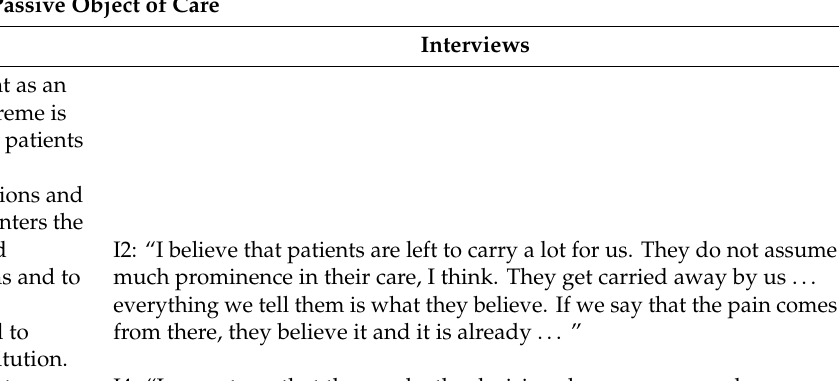
Category: Patient as a Passive Object of